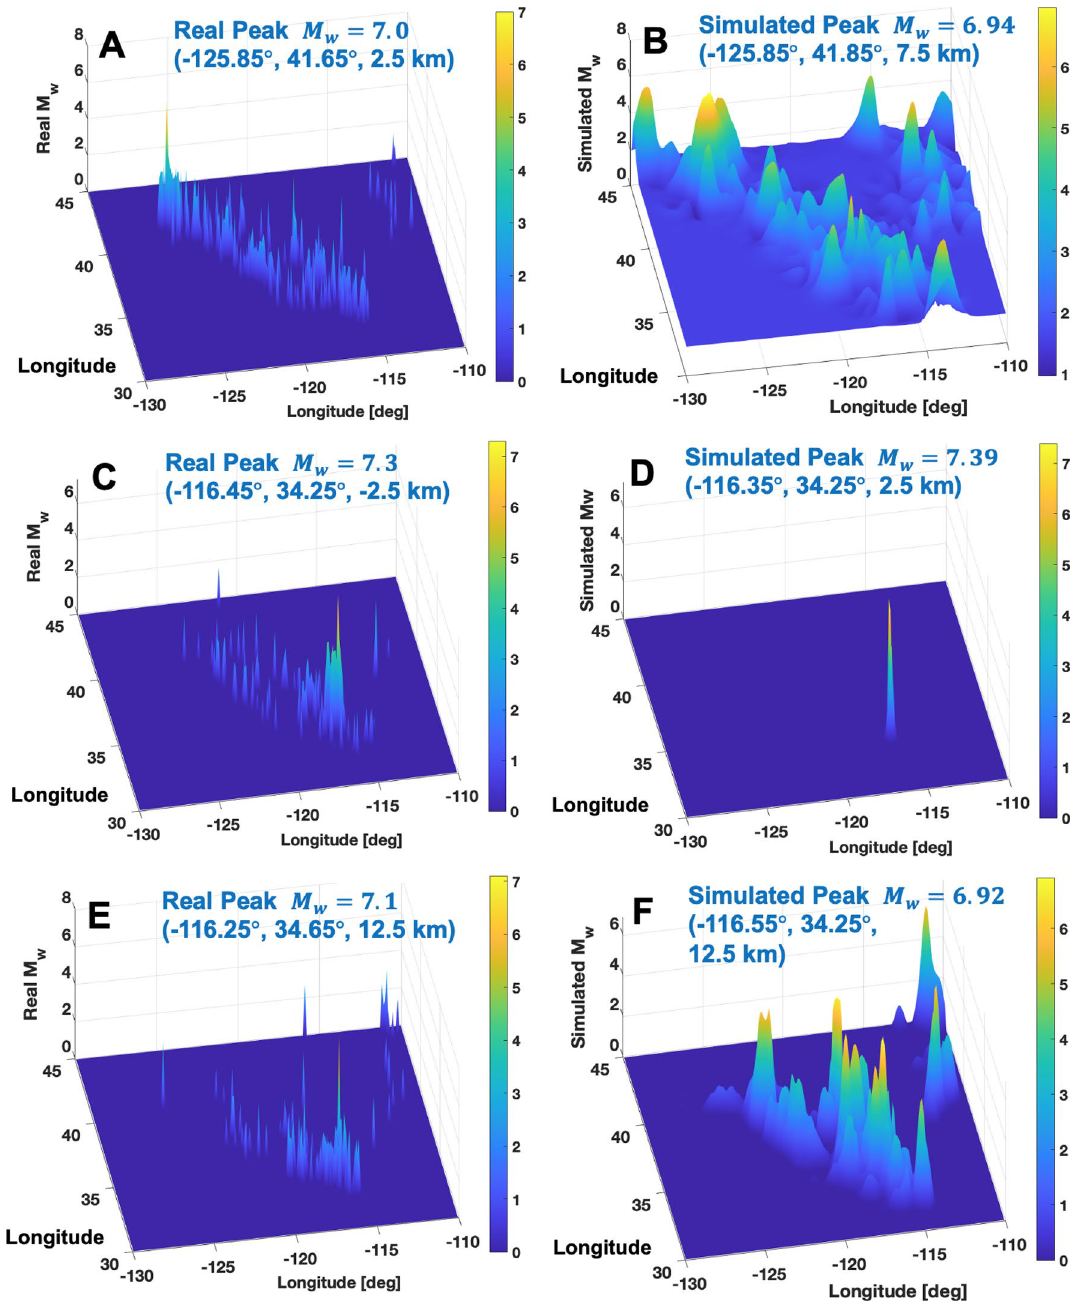
Figure 4. Reproduction of large magnitude events M w > 7.0 by using the customized ML-identified data- driven prediction model: (A,B) Observed real and simulated earthquake events on August 1991 (epoch 10139); (C,D) June 1992 (epoch 10149); (E,F) October 1999 (epoch